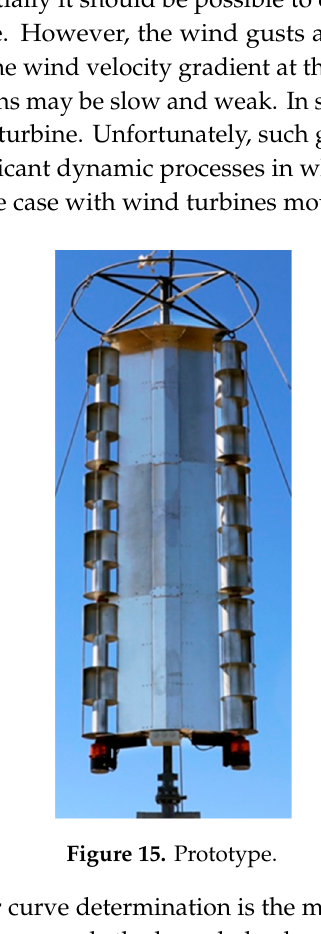
Figure 15. Prototype.